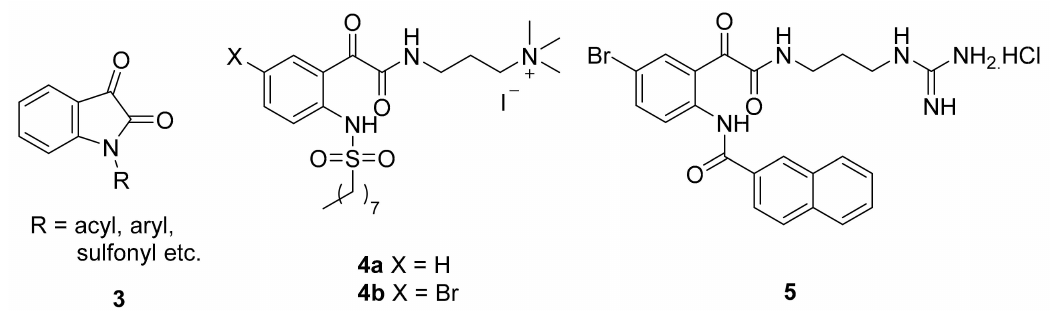
Figure 2. Structures of N -substituted isatin 3 and phenylglyoxamide derivatives 4–5